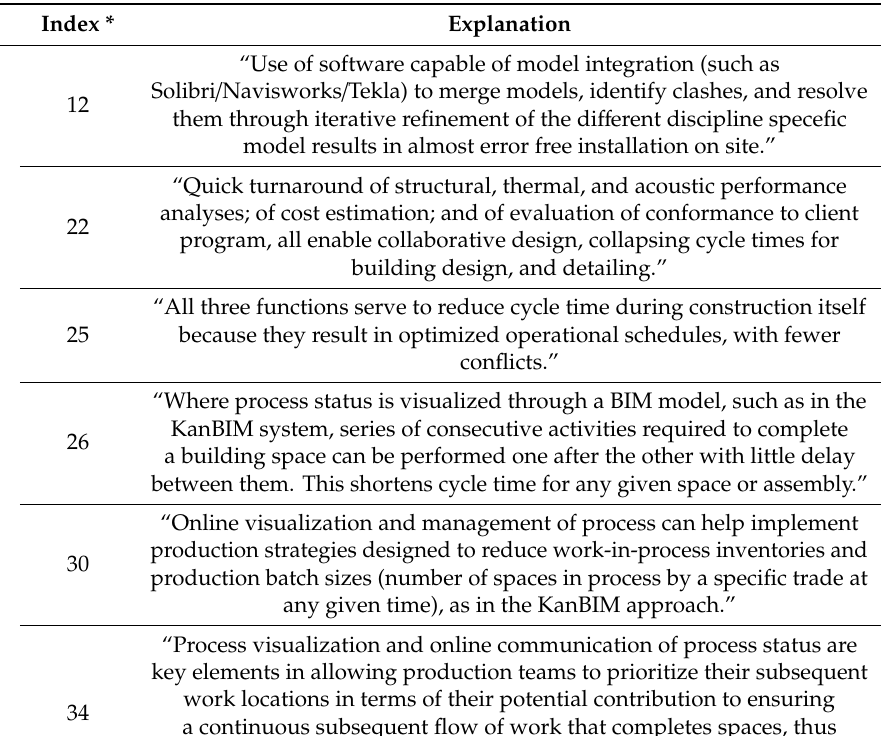
Table A1. BIM-LPS interactions according to the matrix presented in Table